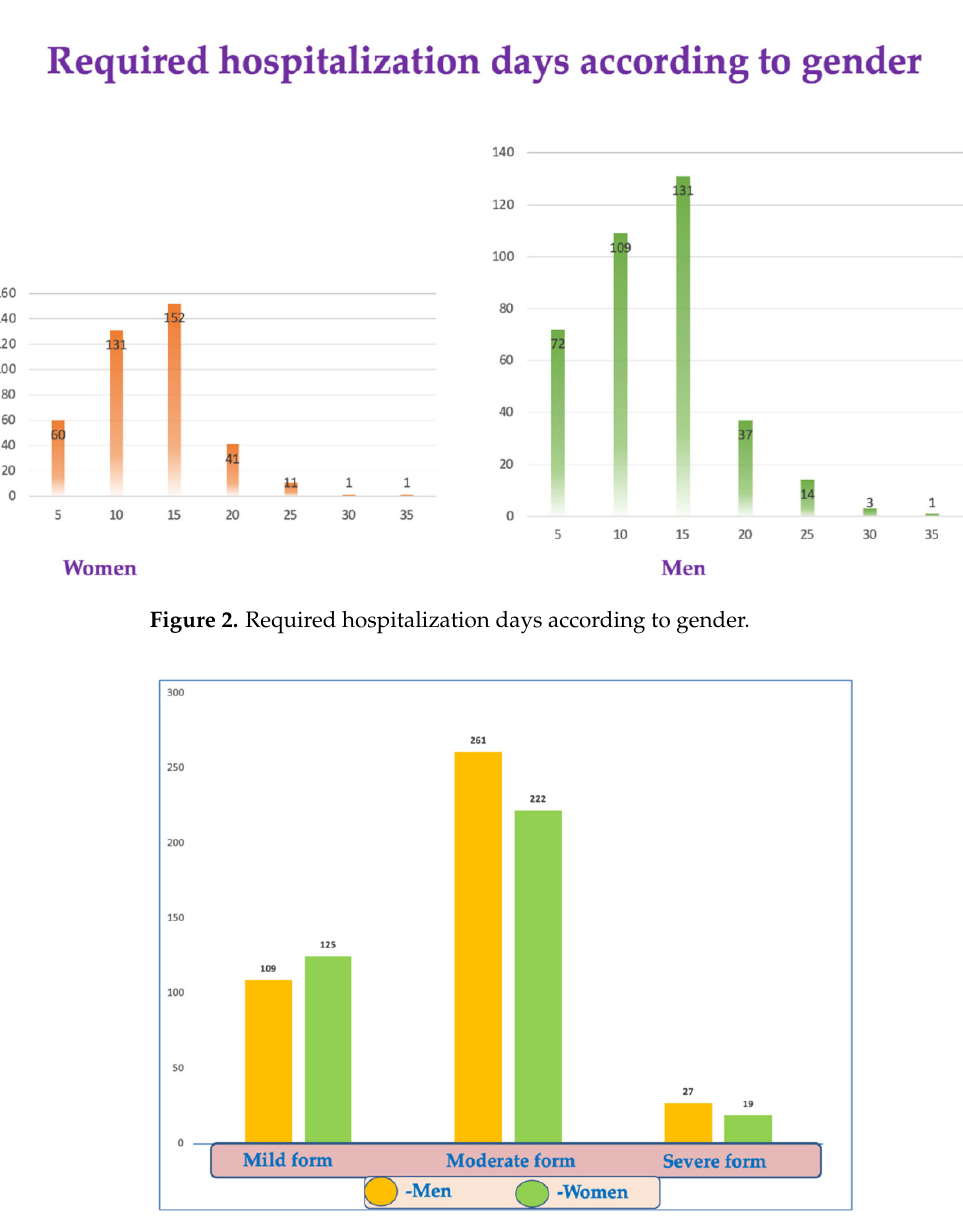
Figure 3. Distribution of COVID-19 disease forms according to gender.